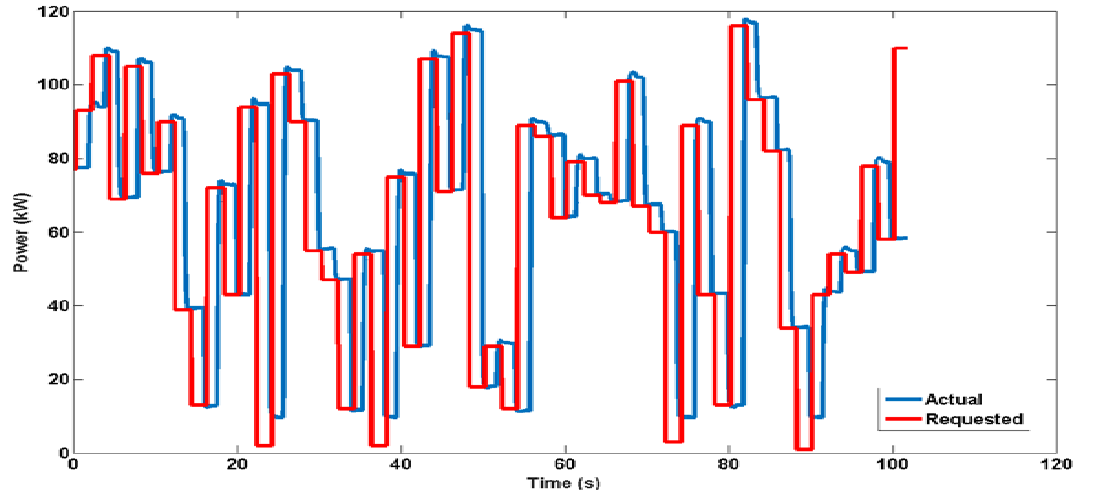
Figure 16. Electrolyzer following a practical utility demand response program